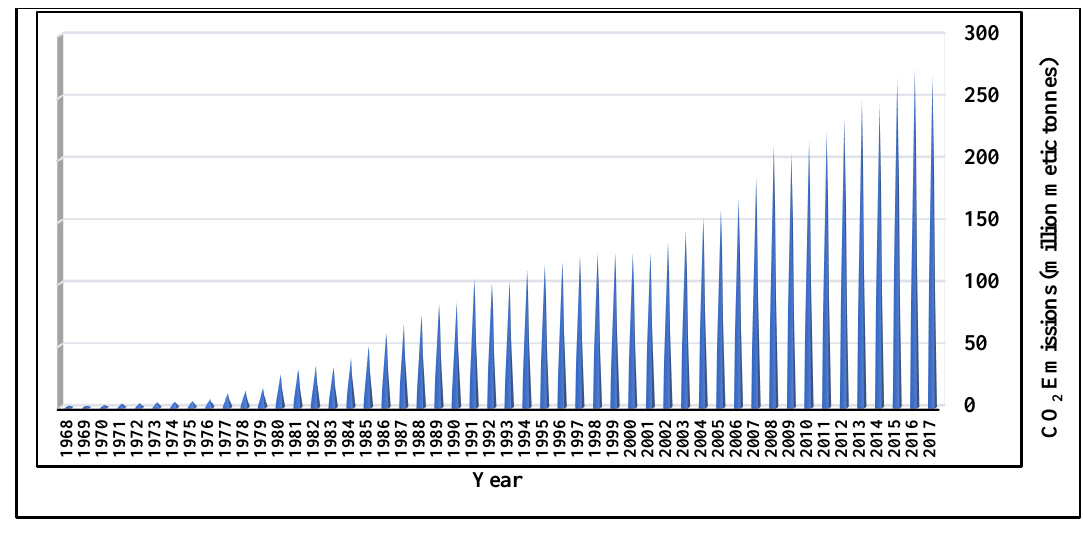
Figure 8. CO 2 emission in the UAE [63].